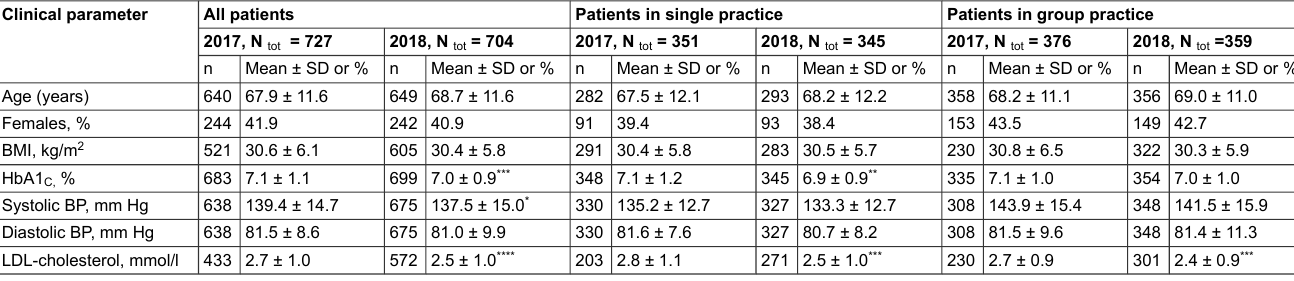
Table 2: Clinical characteristics before and after the implementation of the diabetes score overall and stratified by practice type. Clinical